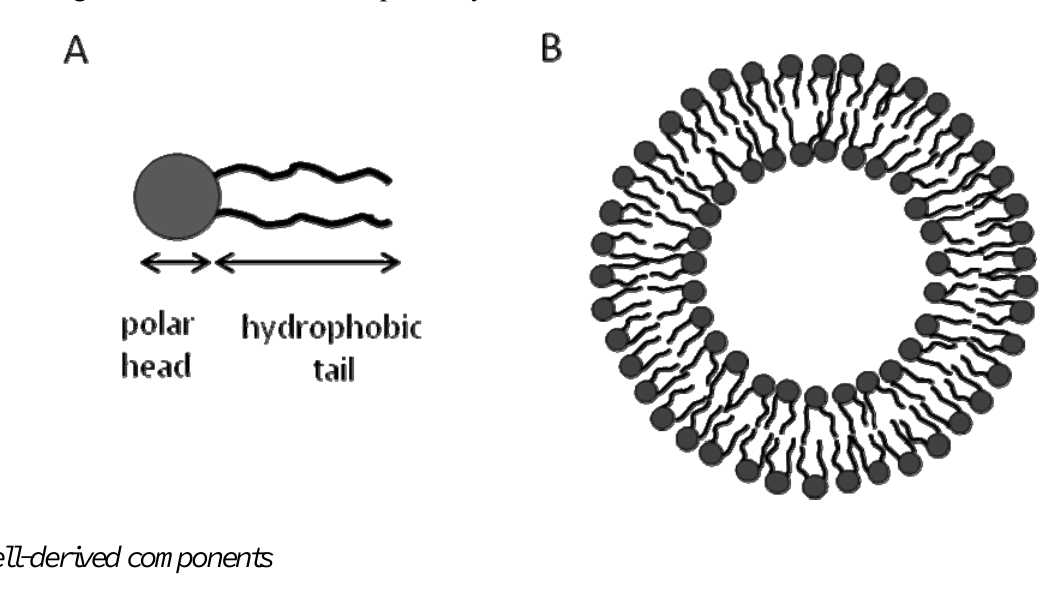
Figure 3. Schematic of a liposome. (A) A schematic of a phospholipid showing the hydrophilic and hydrophobic parts. (B) A cross section in a unilamellar liposome vesicle showing the two leaflets of the lipid bilayer which has a thickness of 5